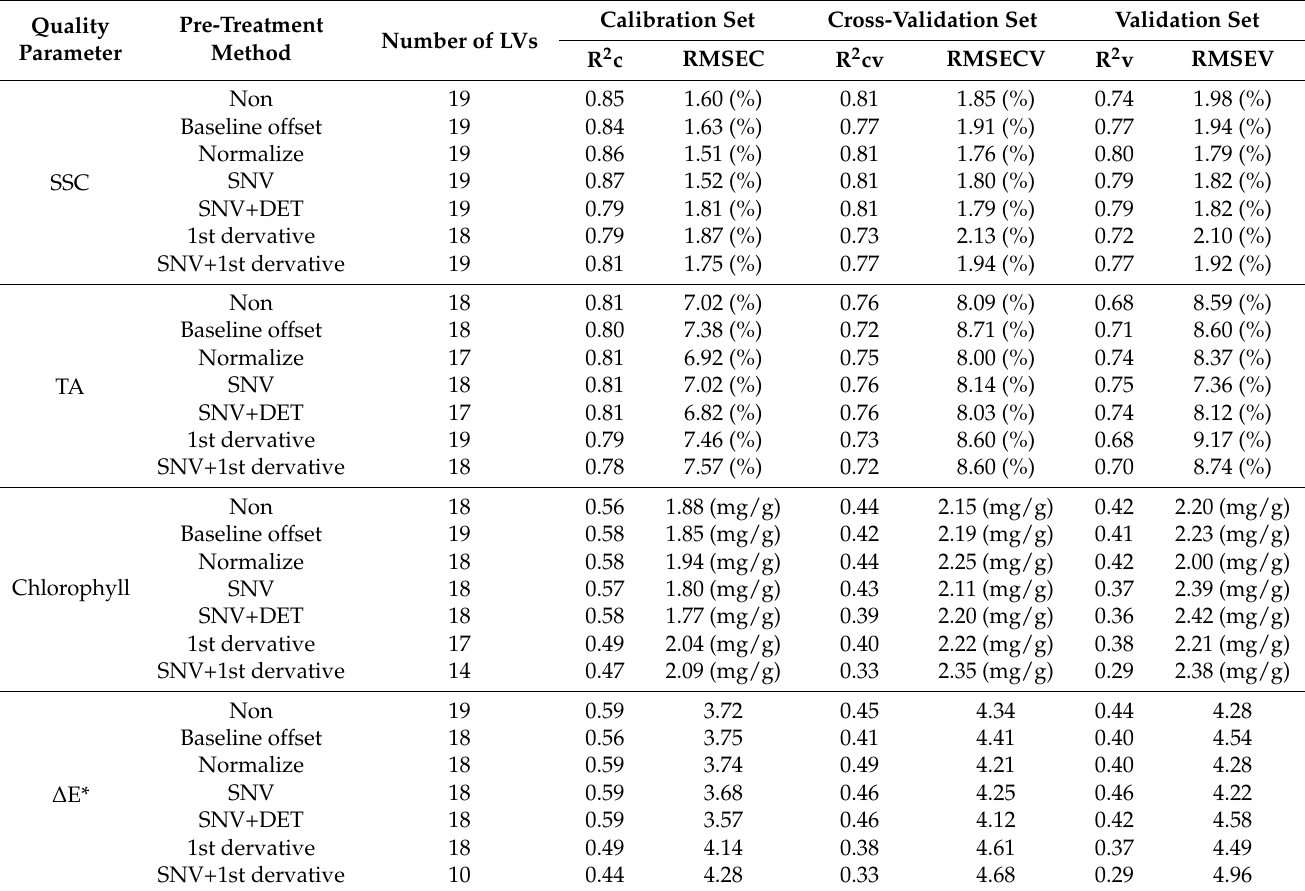
Table 4. Predictive results of the quality